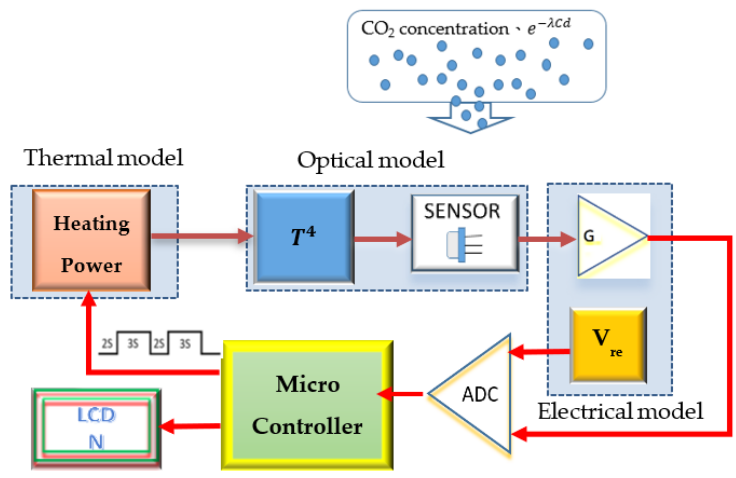
Figure 3. Architecture of the sensing and driving circuit of the direct modulation.